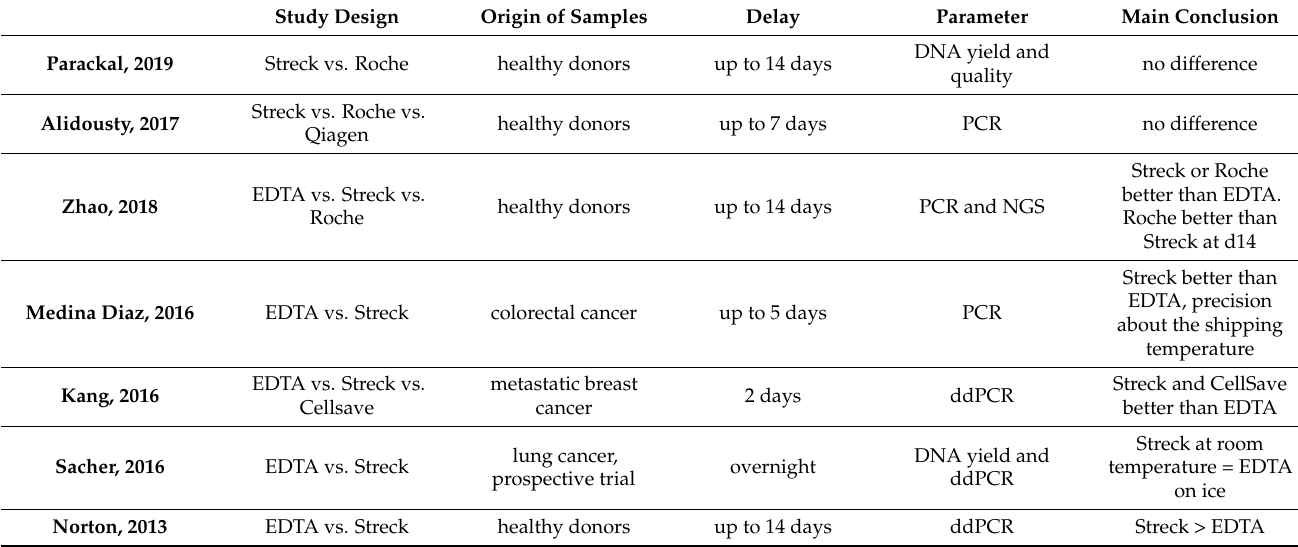
Table 2. Summary of the main comparative studies of blood collection